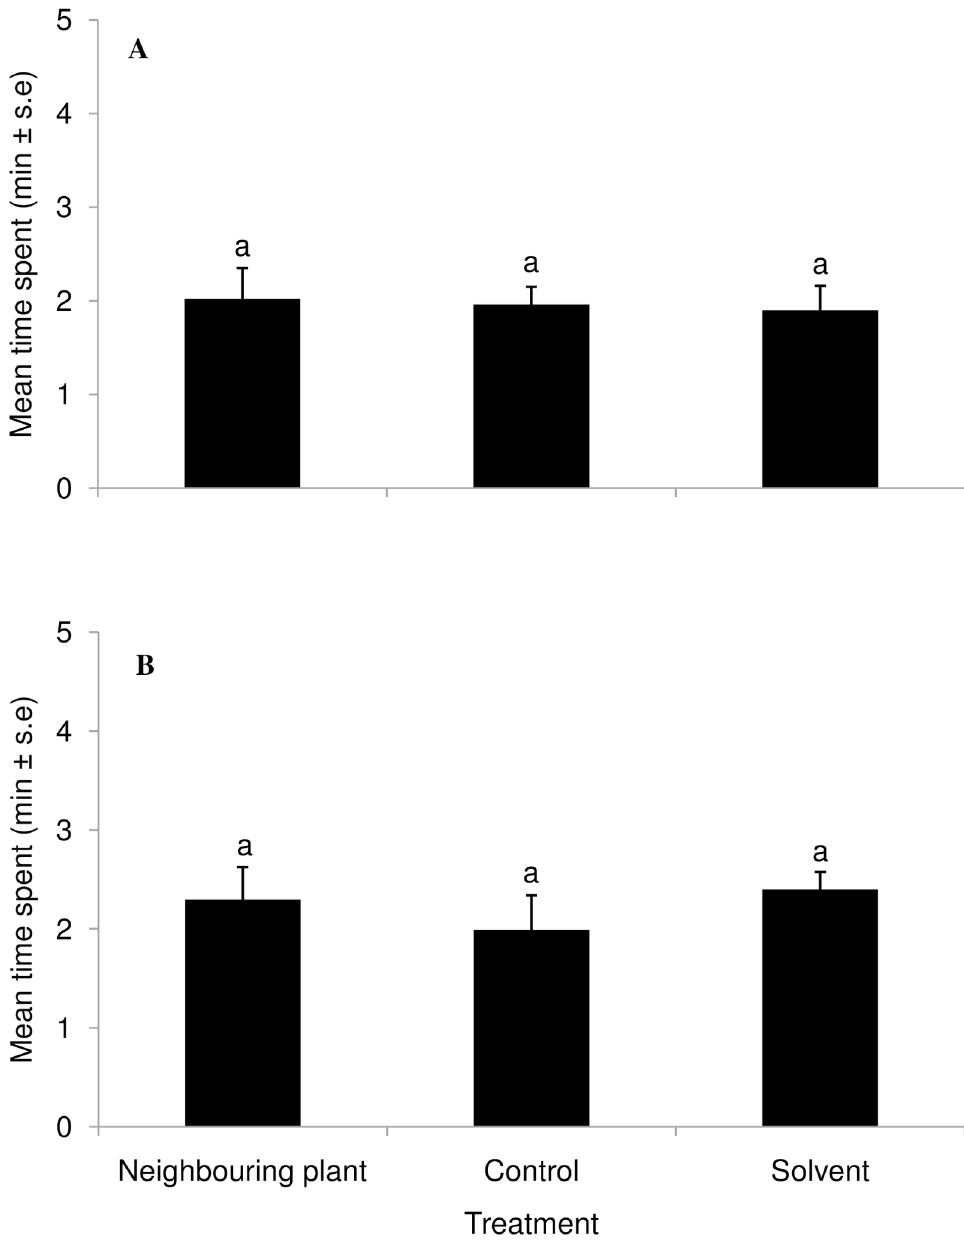
Fig 3. Behavioural response of parasitoids to volatiles collected from a hybrid, HB515, neighbouring induced maize plant (exposed to maize plant emitting egg-induced volatiles) and an unexposed control plant in a four-arm olfactometer bioassay. Response of ( A ) Trichogramma bournieri ; ( B ) Cotesia sesamiae . Bars marked by same letters within a graph are not statistically different ( P >